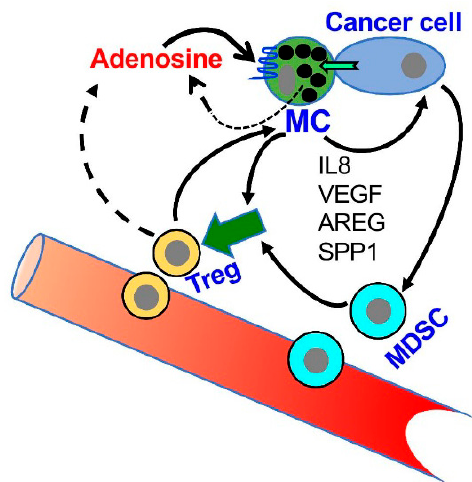
Figure 4. A model of the role of adenosine in the crosstalk among MCs, MDSCs and Treg in the tumor microenvironment (TME). According to this model, MCs migrate to and are activated in the TME; the activated MCs release a panel of factors that influence the attraction and activity of MDSCs and Treg cells (For details see [20,62,64]). In addition, MCs are directly activated by the cancer cells leading to adenosine production and autocrine / paracrine activation of the MCs. Adenosine signaling, that is mediated by the A3R, then leads to the release of angiogenic and tissue remodeling factors, including interleukin 8 (IL8), Vascular endothelial growth factor (VEGF), amphiregulin (AREG) and Secreted Phosphoprotein 1(SPP1, osteopontin) that influence tumor progression.